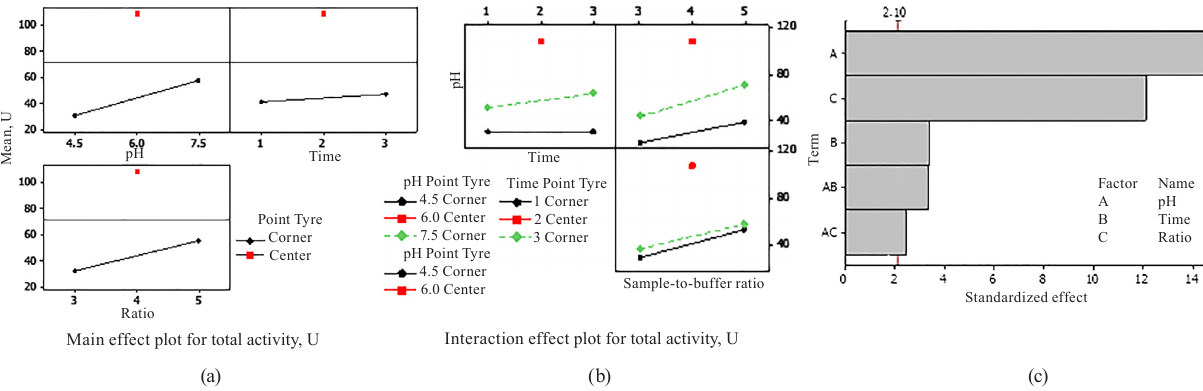
Figure 2 Main effects (a), interaction effects (b), and Pareto chart of extraction variables (c) on total activity of amylase from white pitaya peel